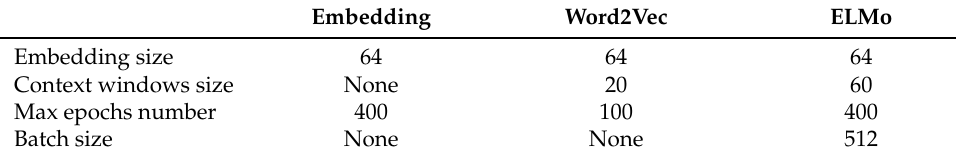
Table 4. Embeddings’ hyperparameters.